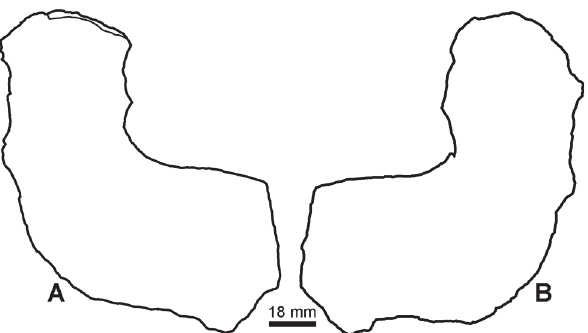
Fig 16. Eoherpeton humerus. New outline drawings of humerus NMS 1993.56.21 (formerly NUZ 78.1.58) in the plane of the entepicondyle. A, ventral, and B, dorsal